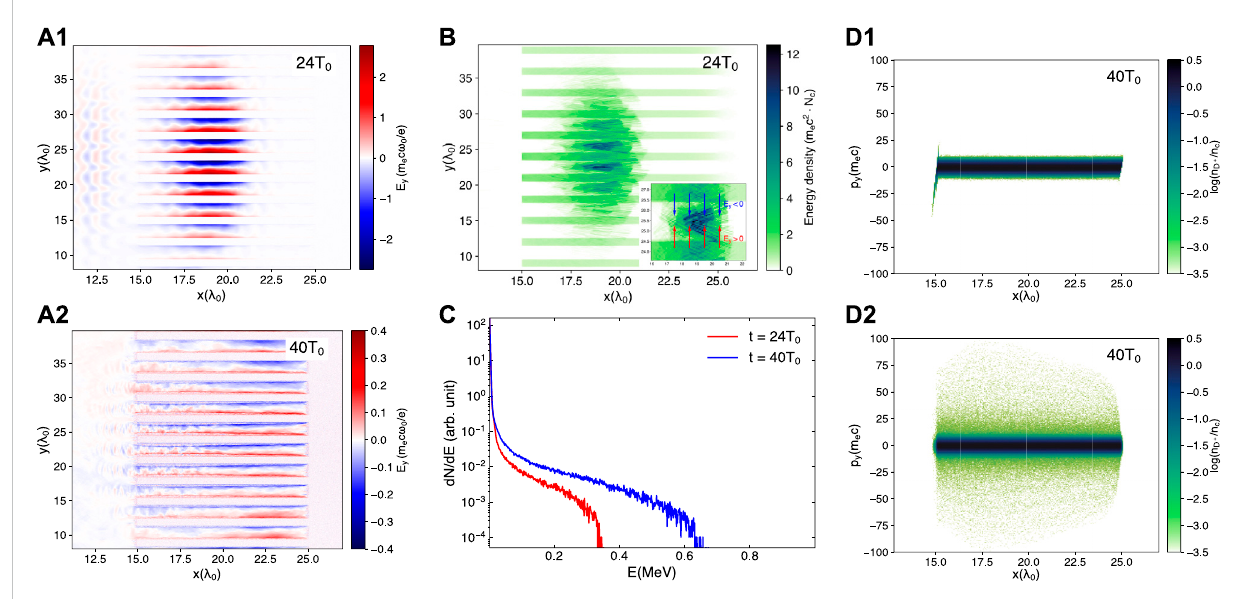
FIGURE 4 Spatial distributionofthetransverse sheath fi eld E sy at (A1) 24T 0 and (A2) 40T 0 . (B) The electron energydensity averaged overa laser cycle. The fi eld formed by the charge separation is represented by a sub fi gure in the lower right corner. (C) Energy spectrum of wires deuterons at different times. (D1) The x-p x phase diagrams and (D2) The x-p y phase diagrams of the D + ions at 40T 0 .